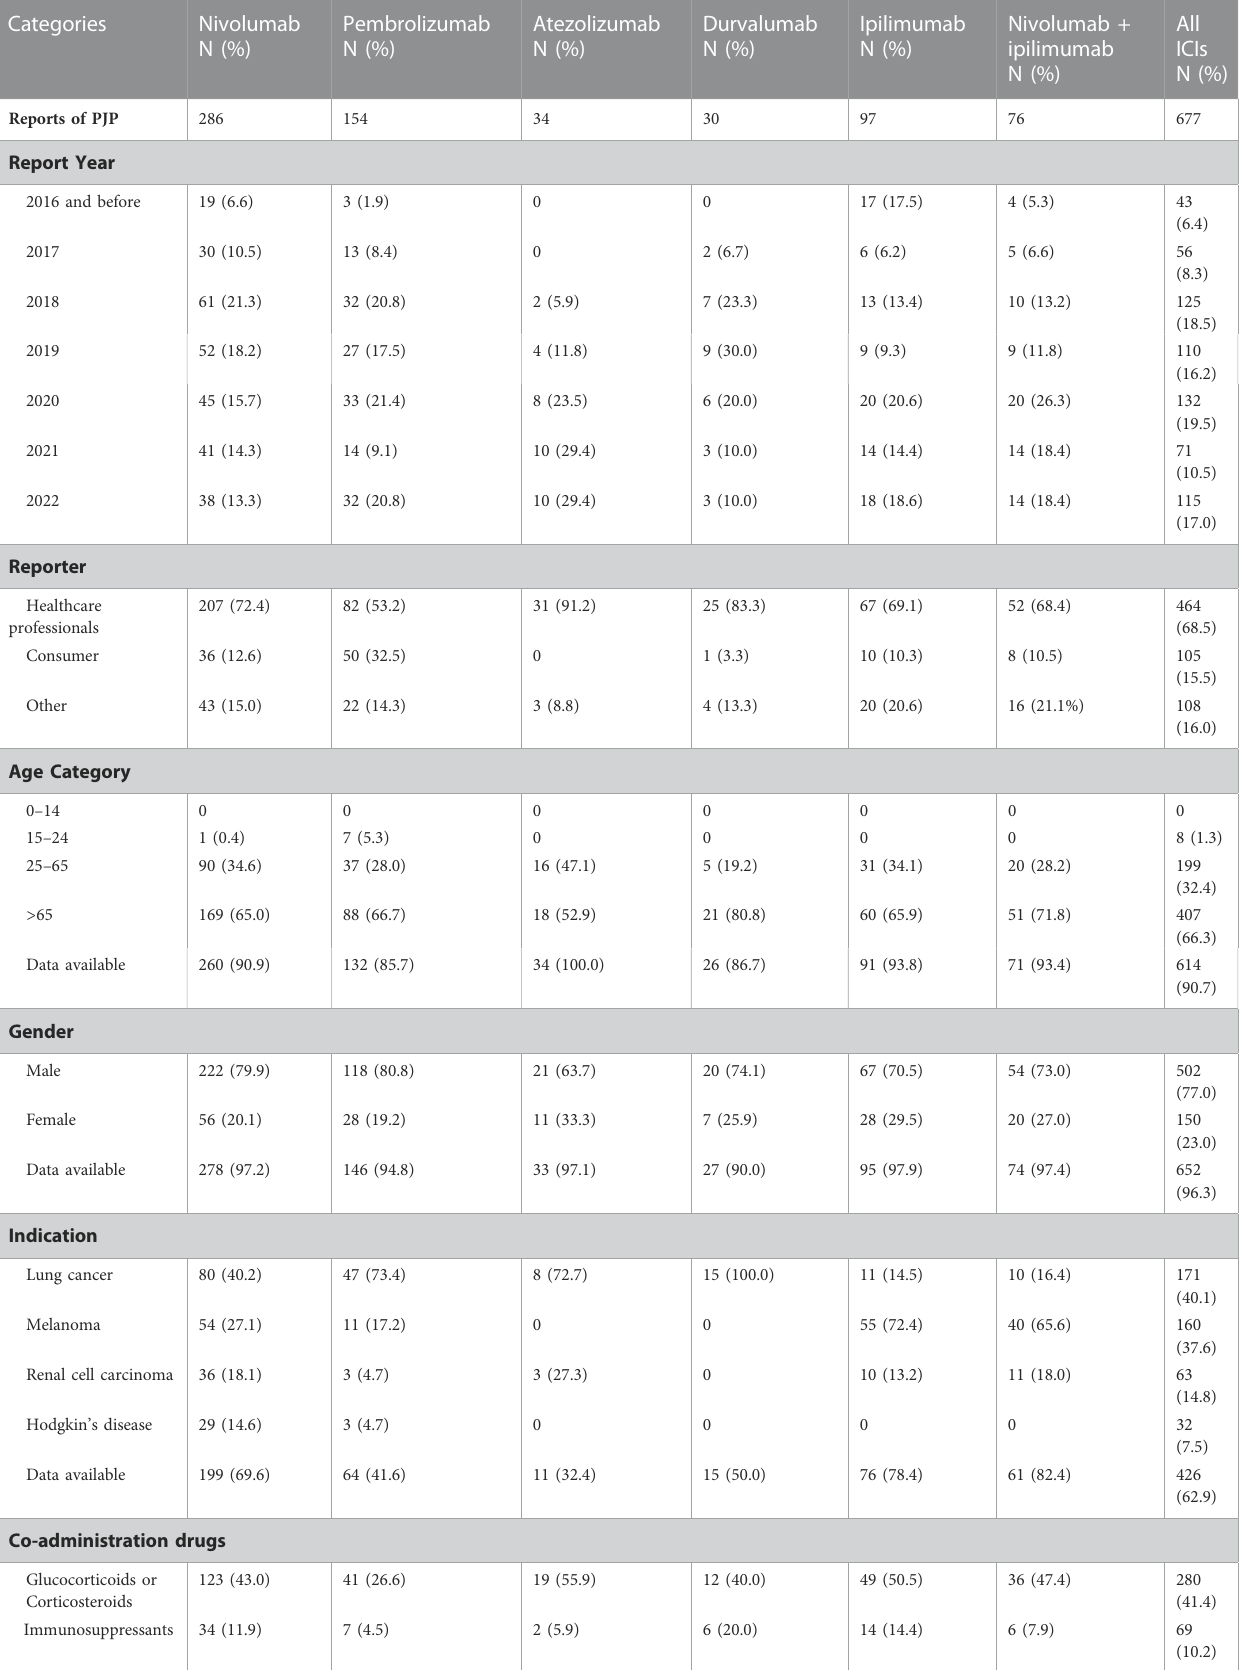
TABLE 3 Patient characteristics of PJP reports with immune checkpoint inhibitors in FAERS